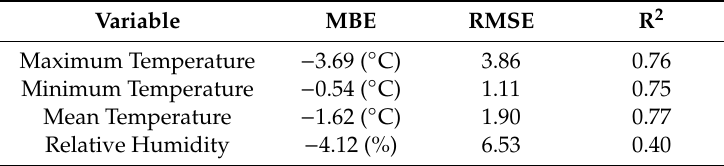
Table 2. Evaluation of the 4 km simulation for the summer of 2016 using the 53 stations. Variable MBE